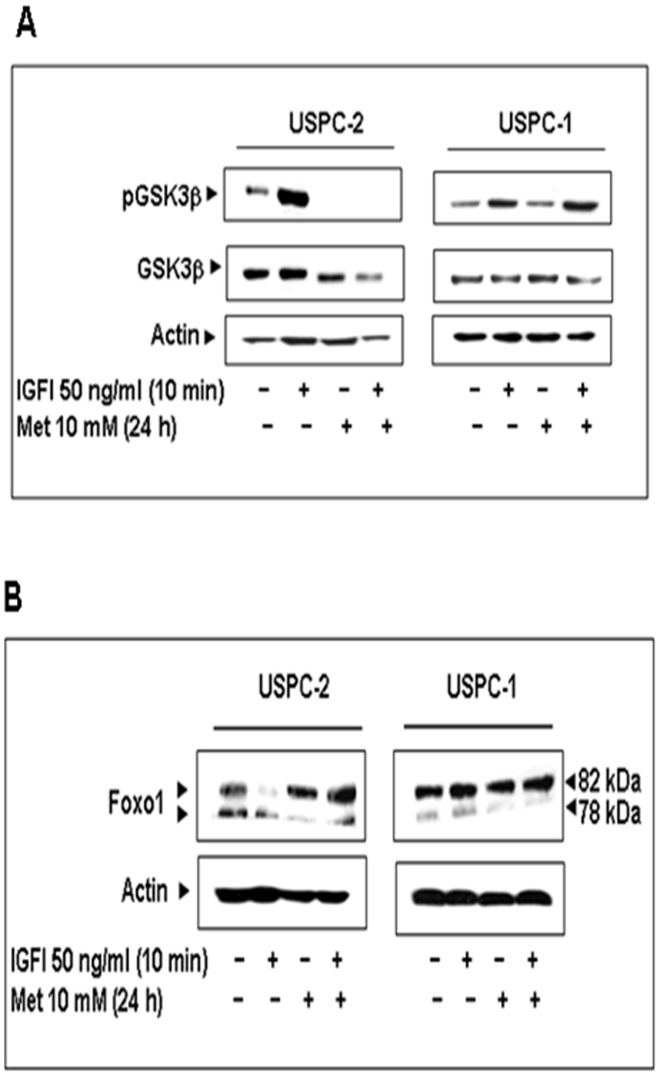
Effect of metformin on GSK3ß and Foxo1 expression.A, Western blot of pGSK3ß and GSK3ß in USPC-2 and USPC-1 cells treated with metformin for 24 h and/or IGF-I. The figure shows the results of a typical experiment repeated three times. B, Western blot analysis of Foxo1 on USPC-2 and USPC-1 cells treated for 24 h with metformin and/or IGF-I. The figure shows the results of a characteristic experiment, repeated three times with similar results.